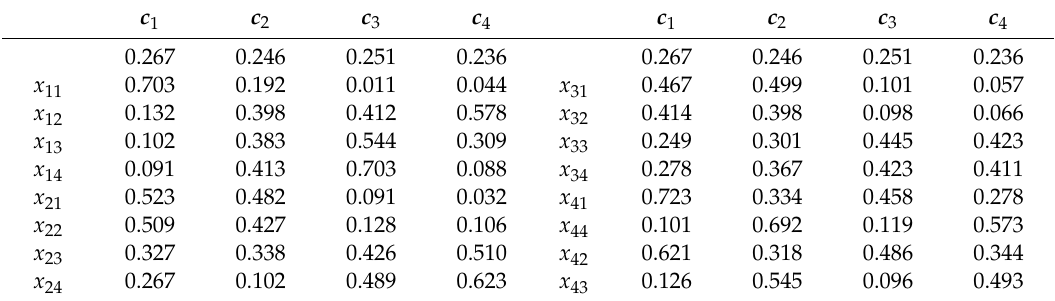
Table 1. Prior probability of tourist site classification and conditional probability of feature